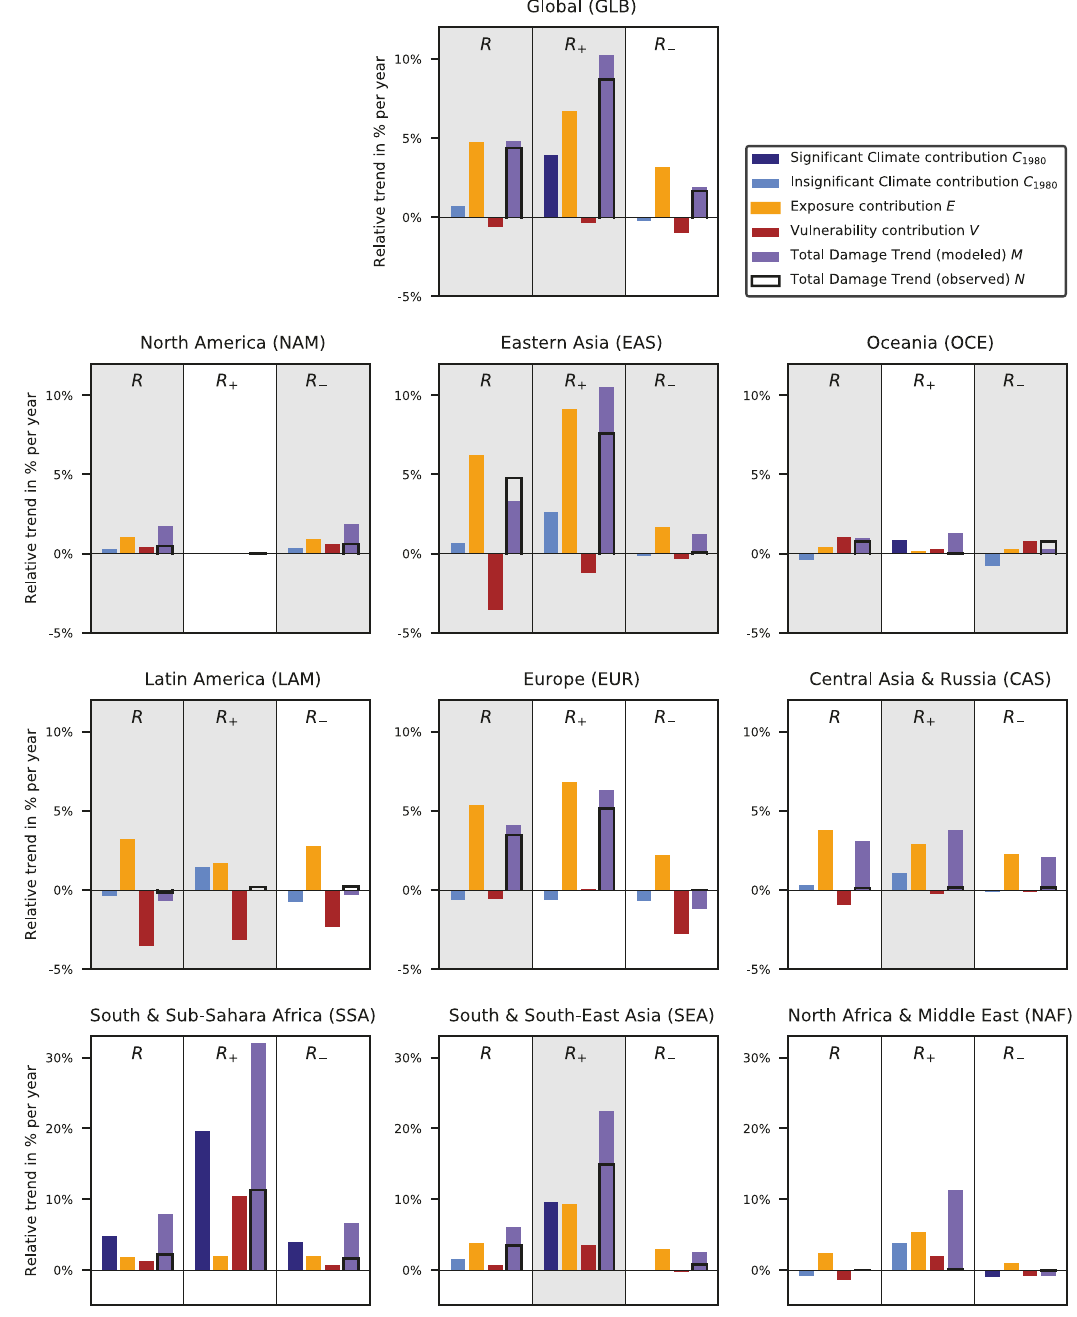
Fig. 3 Contributions of changes in climate, exposure, and vulnerability to damages induced by river fl oods (1980 – 2010). Bars indicate the relative trend in annual modeled M (purple) and observed damages N (black frames) and the individual contributions of each driver: climate C 1980 (blue), exposure E (orange), vulnerability V (red) relative to the recorded annual mean damage of the baseline period 1980 – 1995. From left to right, we present the trends in the entire world regions ( R ), and the subregions with positive ( R + ) and (negative, R – ) discharge trends. Gray background colors highlight the regions where the explained variance of the full model is higher than